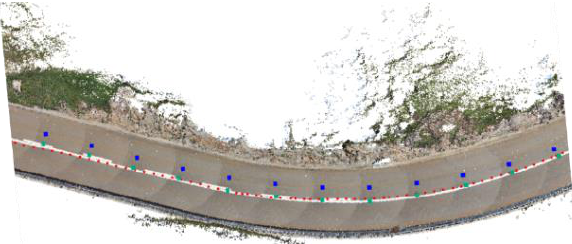
Figure 13. Comparison between the polylines of the ground truth, the alignment and the trajectory. Ground truth in red, alignment in green and trajectory in blue.